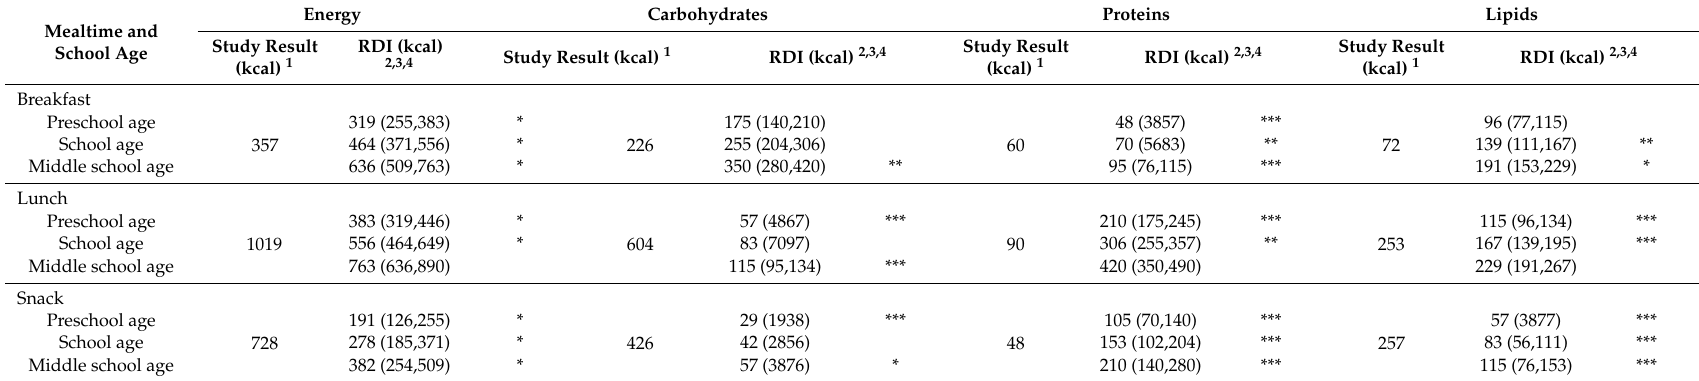
Table 3. Comparison between nutritional content of school-age children’s meals with daily intake recommended by age groups